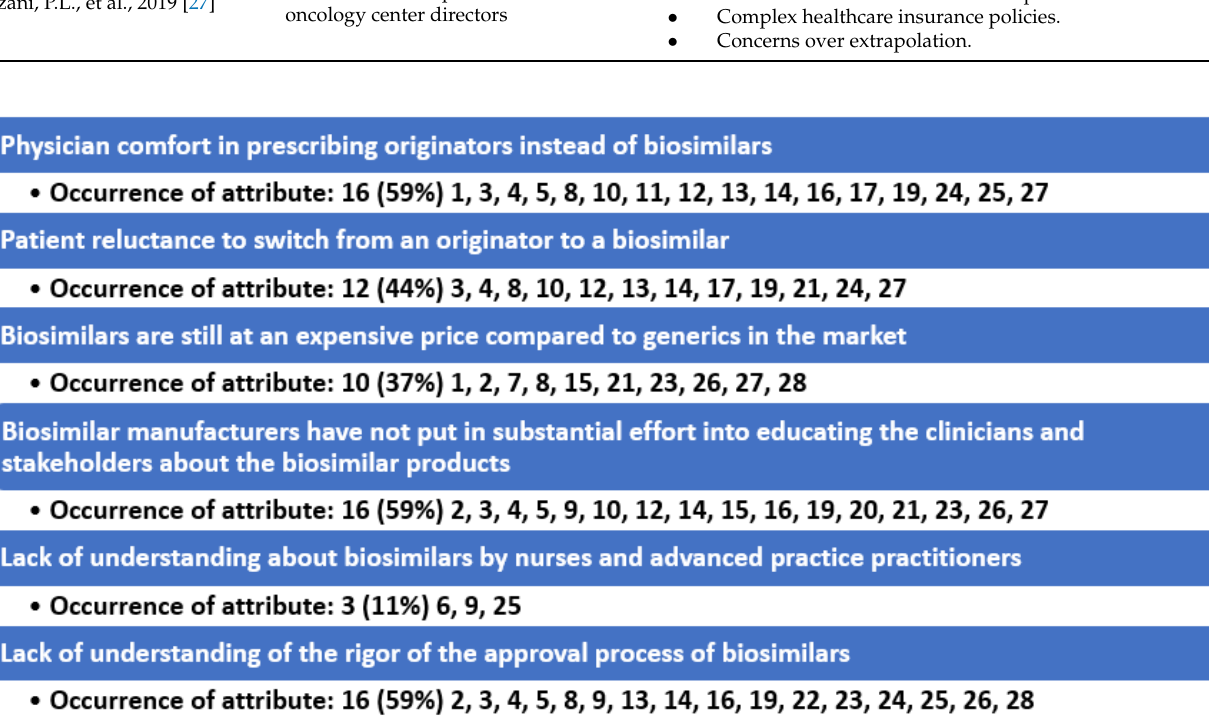
Figure 2. Identified themes (constructs) identified as barriers to the implementation of biosimilar oncology